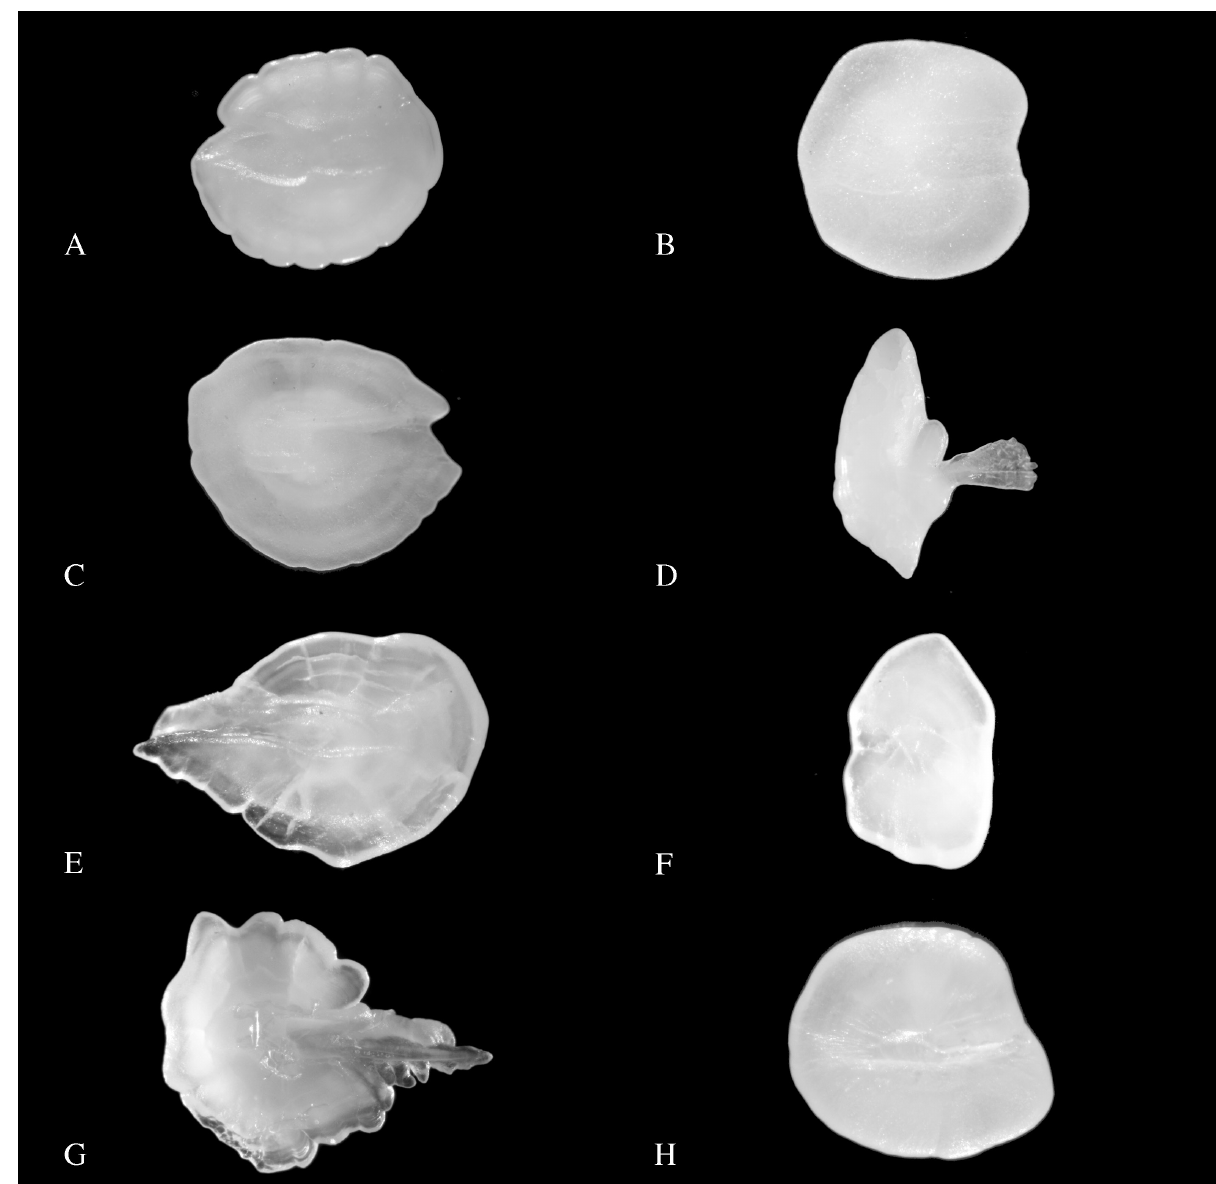
Fig . 3. – A, Hygophum hygomii (SL = 28.7 mm; W = 0.37 g), right otolith (OL = 1.69 mm; OW = 1.48 mm); B, Lampanyctus pusillus (SL = 37.4 mm; W = 0.51 g), left otolith (OL = 1.05 mm; OW = 1.05 mm); C, Myctophum punctatum (SL = 73.7 mm; W = 5.72 g), left otolith (OL = 3.29 mm; OW = 2.69 mm); D, Ichthyococcus ovatus (SL = 35.7 mm; W = 1.06 g), left otolith (OL = 3.16 mm; OW = 3.88 mm); E, Vinciguerria attenuata (SL = 35.8 mm; W = 0.42 g), rigth otolith (OL = 1.39 mm; OW = 0.94 mm); F, Argyropelecus hemigymnus (SL = 34.0 mm; W = 0.87 g), rigth otolith (OL = 0.60 mm; OW = 0.90 mm); G, Maurolicus muelleri (SL = 45.0 mm; W = 1.33 g), left otolith (OL = 2.05 mm; OW = 1.61 mm); H, Chauliodus sloani (SL = 201.9 mm; W = 18.50 g), left otolith (OL = 0.99 mm; OW = 0.89